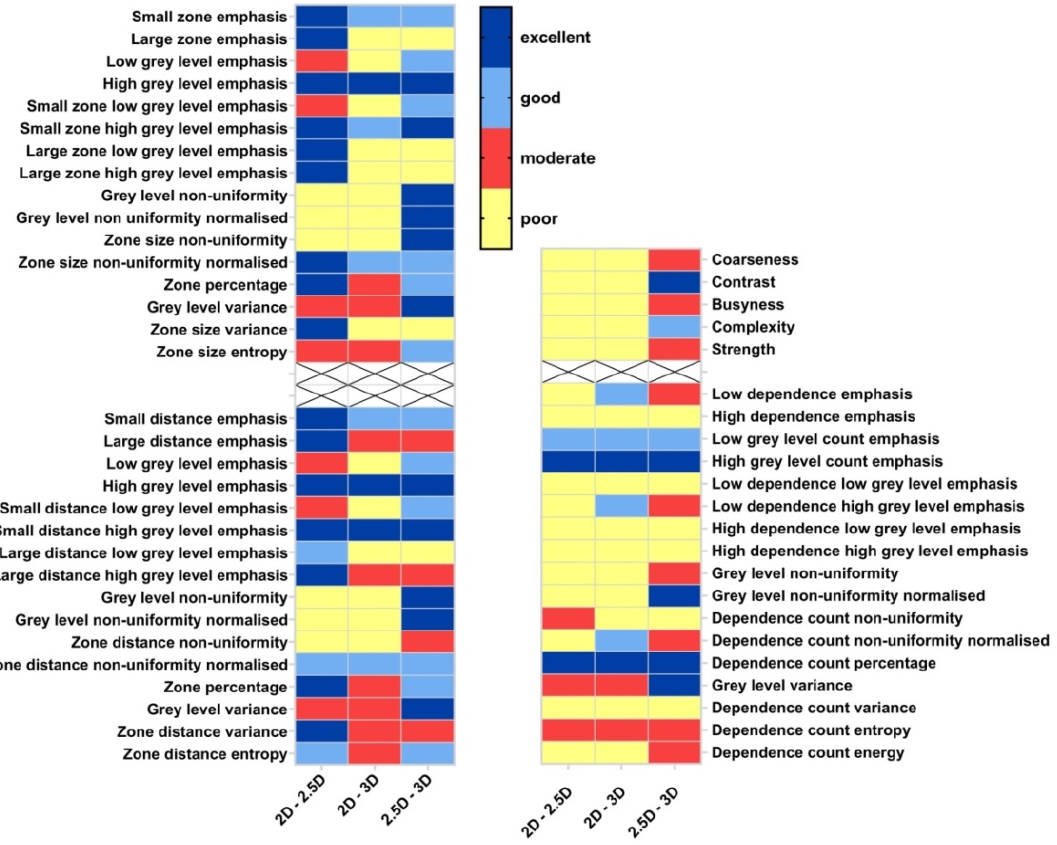
Figure 7. ICC heat map of GLSZM ( top-left ), GLDZM ( bottom-left ), NGTDM ( top-right ) and NGLDM ( bottom-right ) features; volumes: pair-wise aggregation methods corresponding to Figure 2; rows; GLCM features. Blue = ICC > 0.9 (excellent), light blue = 0.75 ≤ ICC < 0.9 (good), red = 0.5 ≤ ICC < 0.75 (moderate), yellow = ICC < 0.5 (poor).